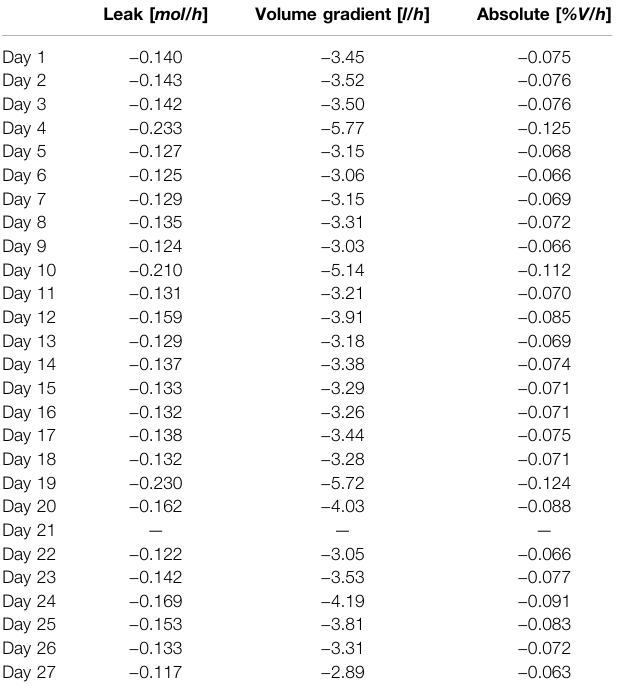
TABLE5| Dailymassbalancecomputationintermsof%ofvolumeperhourinthe 27 days life test on lettuce in the PCU. Leak [ mol/h ]